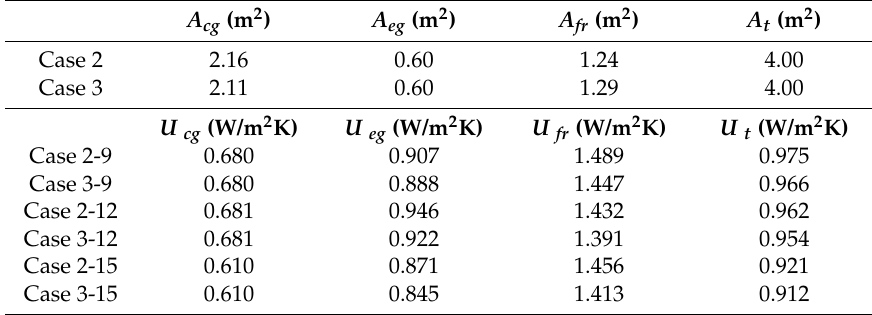
Table 10. Variation in areas and U-factors between Cases 2 and